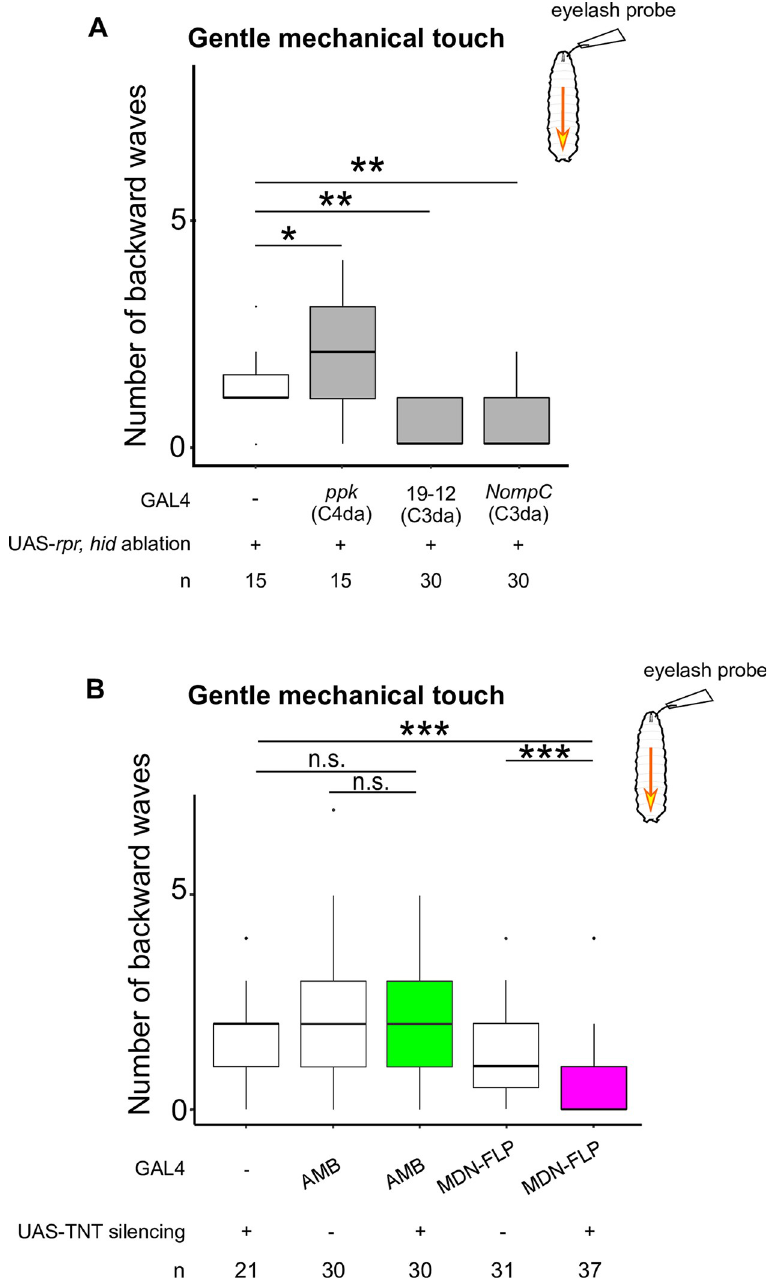
Fig 8. Gentle touch-induced backward waves are mediated by C3da and require MDN activity The number of backward waves in response to gentle touch with ablation of sensory neurons (A) or silencing AMBs or MDNs (B). Gentle touch was applied four times with 15 seconds intervals. Genotypes are shown in S1 Table. In the boxplot, the width of the box represents the interquartile range. The whiskers extend to the data point, which is less than 1.5 times the length of the box away from the box, and the dot represent the outlier. We assessed the statistical significance by the Wilcoxon rank-sum test with the Holm method. � p < 0.05, �� p < 0.01, ��� p < 0.001.